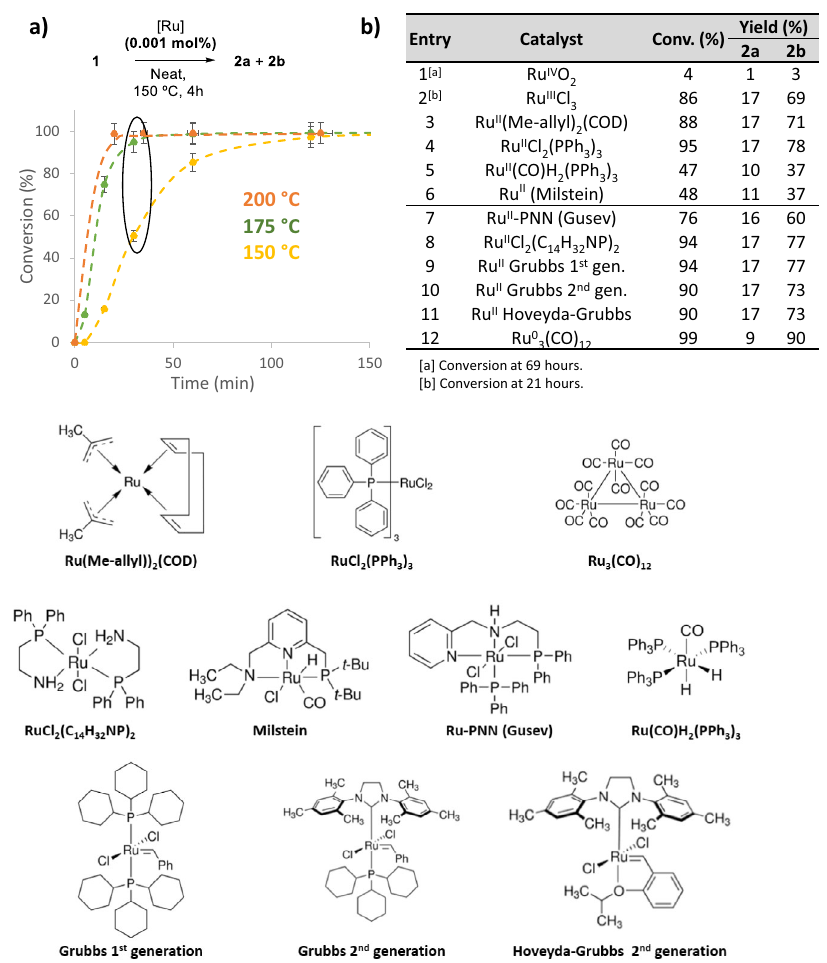
Fig. 2 A variety of Ru catalysts and reaction temperatures are suitable for the chain – walking reaction of methyl eugenol 1 to methyl isoeugenol 2. a Kinetics for the isomerization reaction of 1 g of 1 with Ru(methylallyl) 2 (COD) at three different reaction temperatures; error bars account for a 5% uncertaintity. b Isomerization reaction catalyzed by 0.001 mol% (10 ppm) of different commercially available Ru compounds, the Ru oxidation state for each compound is indicated. For entries 1 – 6, the reaction was carried out with 4 – 16 g of 1 adding the solid catalyst directly. For entries 7 – 12, the reaction was carried out with 0.3 – 1 g of 1 adding a solution of the catalyst in dichloromethane. Below, structures of the different Ru complexes employed as initial Ru